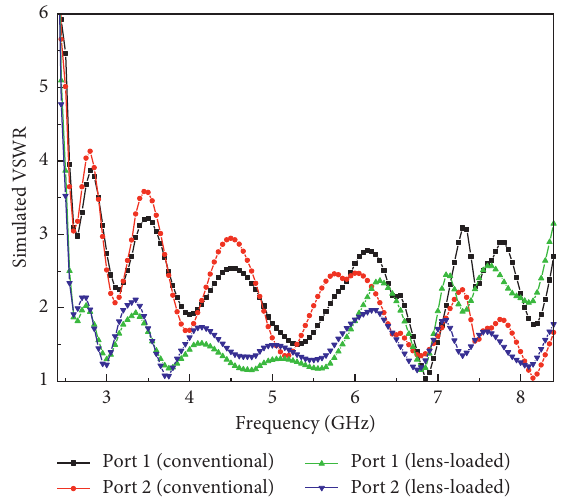
Figure 3: The simulated VSWR data of the conventional and lens-loaded